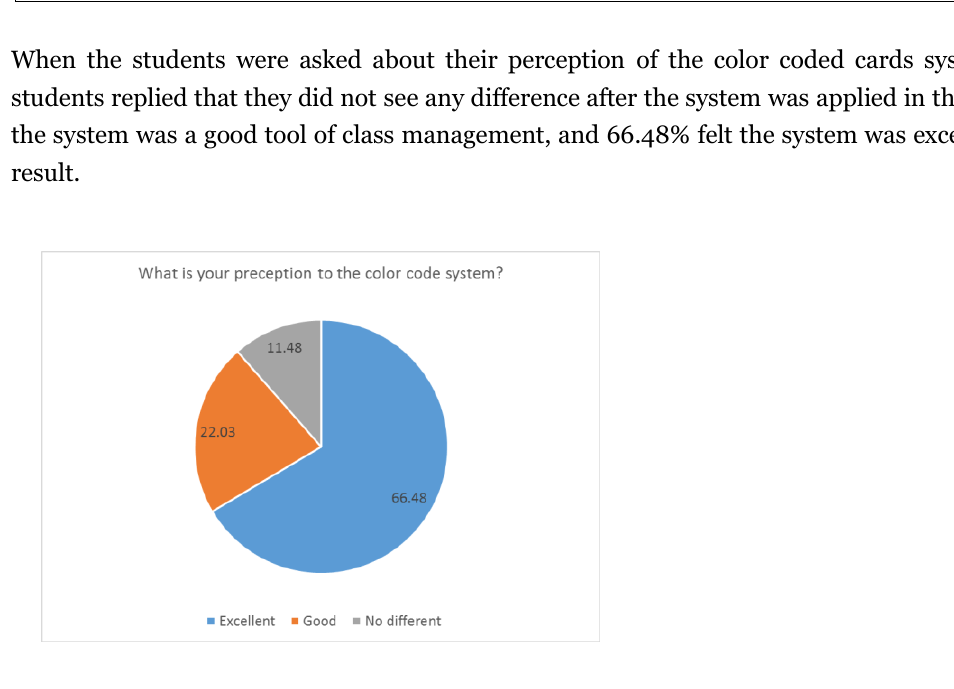
Figure 1. Perception of the